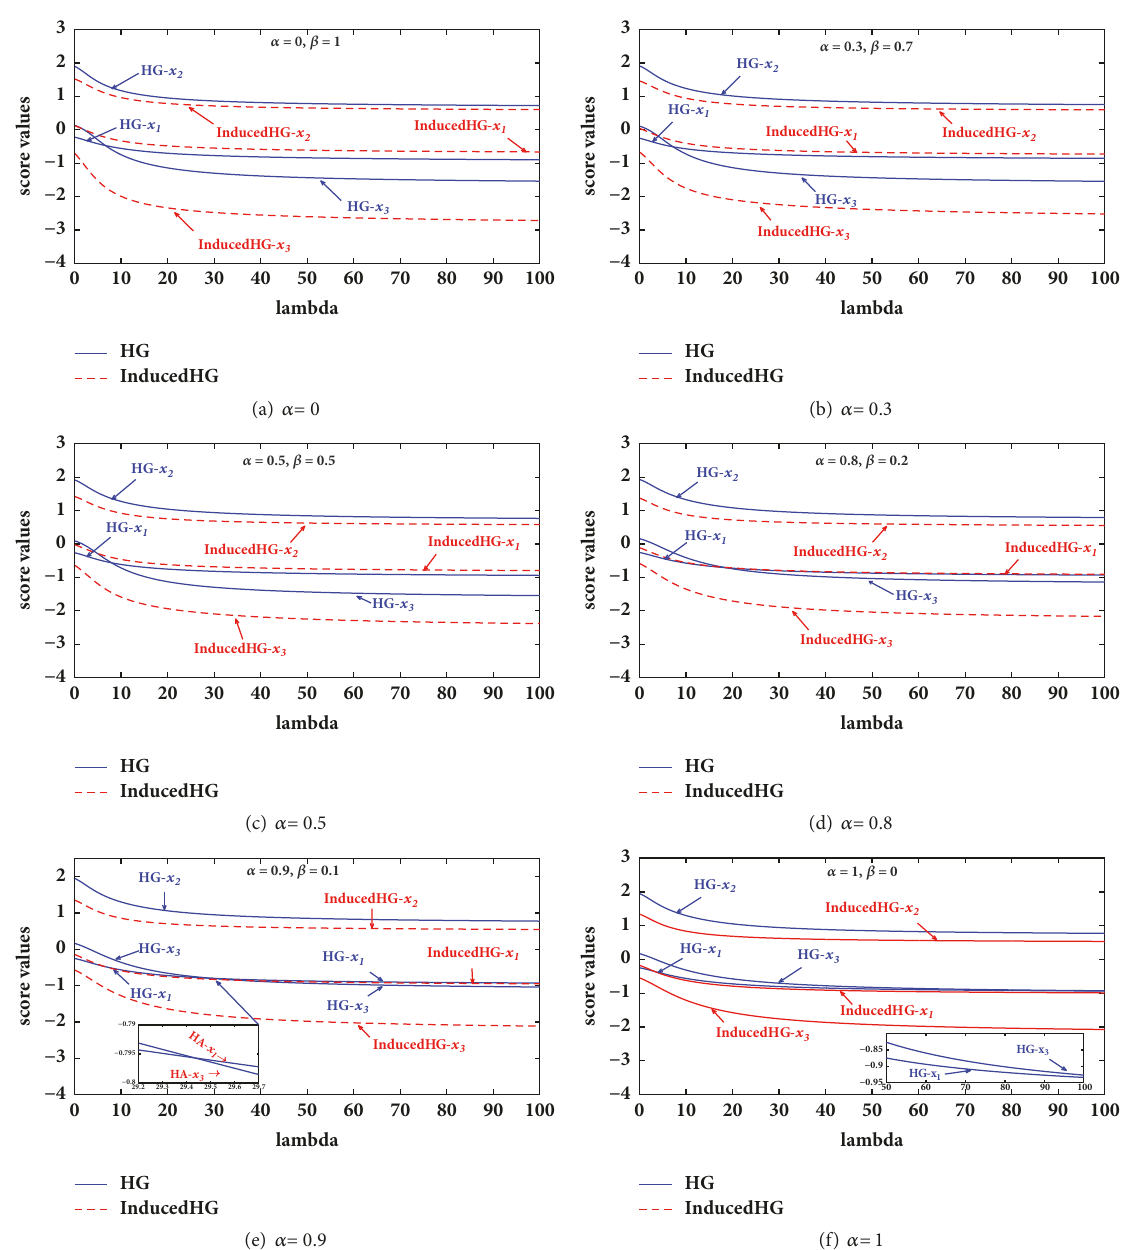
Figure 6: Score trajectories obtained by aggregation operators HG and InducedHG with different configuration of 𝛼 : (a) 𝛼 = 0, (b) 𝛼 = 0.3, (c) 𝛼 = 0.5, (d) 𝛼 = 0.7, (e) 𝛼 = 0.9, and (f) 𝛼 =